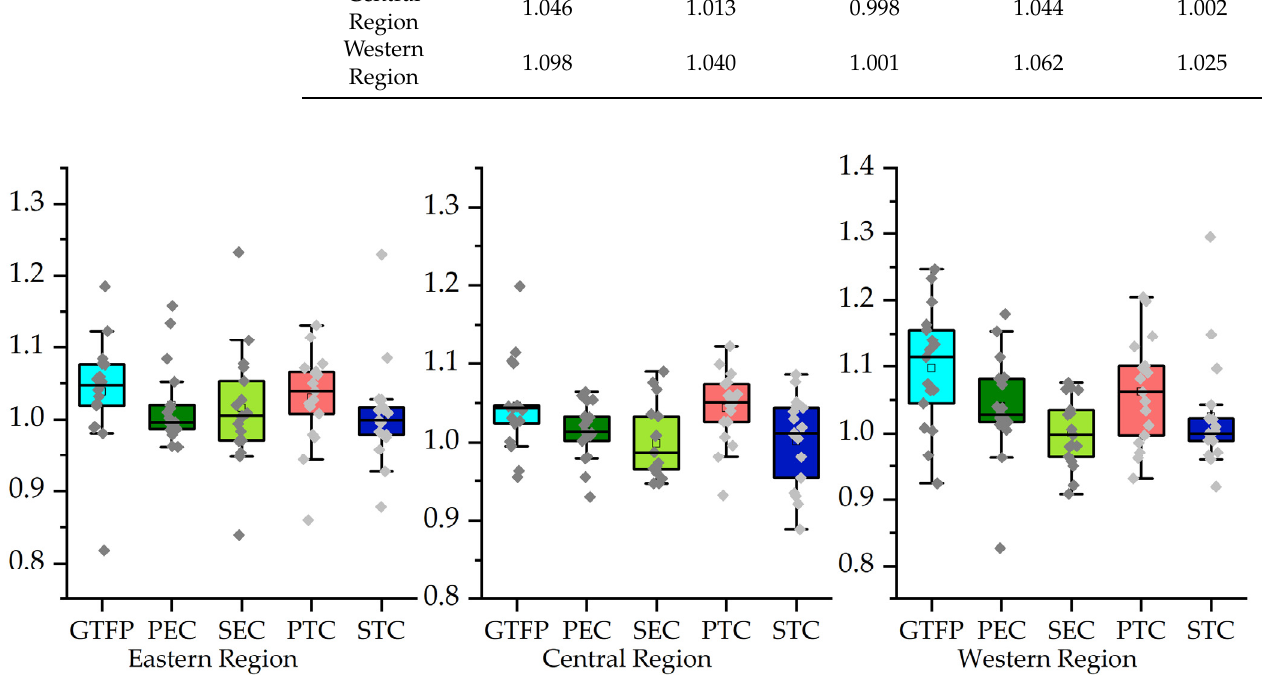
Figure 9. FGTFP index decomposition by regional division.